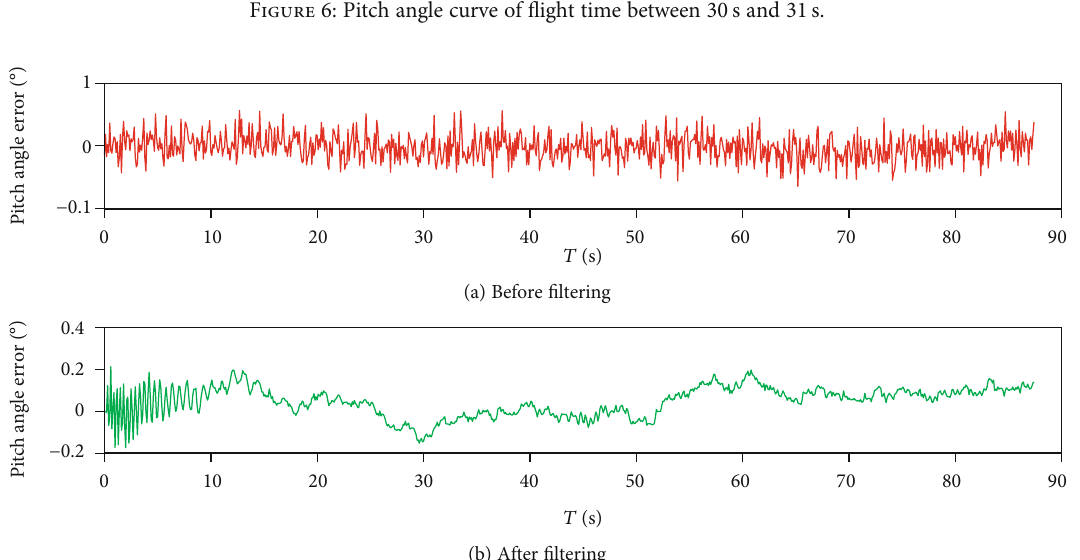
(b) After fi ltering Figure 7: Comparison of pitch angle error before and after fi